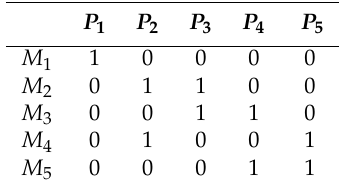
Table 1. Reachable markings’ set of the